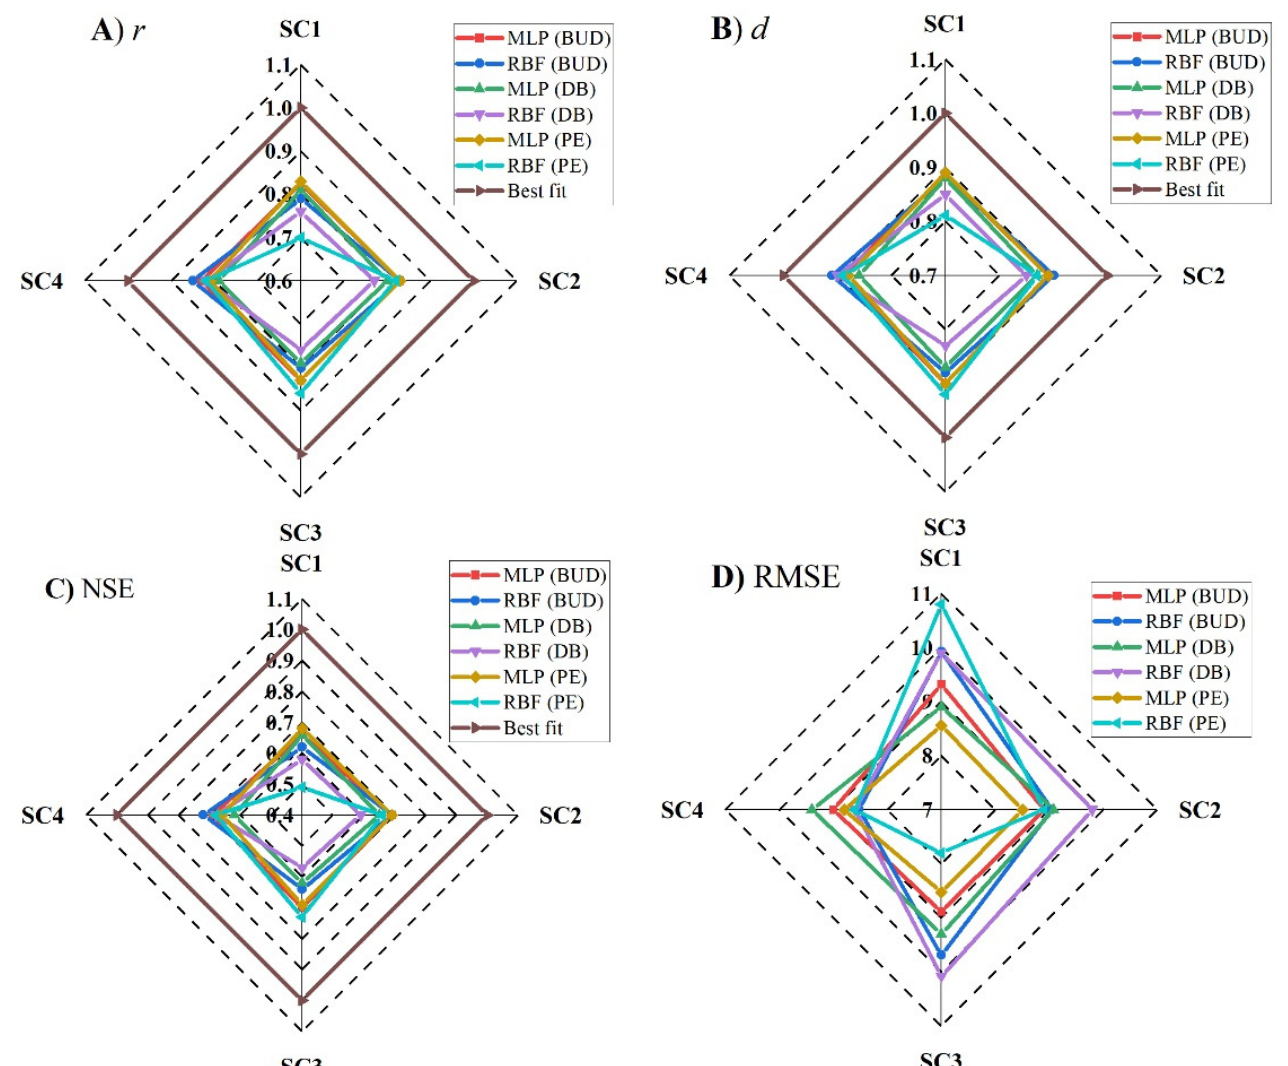
Figure 7. Performance analysis of ANN (MLP and RBF) algorithms in predicting MFI values under four scenarios (SC1, SC2, SC3, and SC4) at three stations in Budapest (BUD), Debrecen (DB), and Pecs (PE): ( A ) Pearson correlation coefficient ( r ), ( B ) index of agreement correlation ( d ), ( C ) model efficiency (NSE), and ( D ) root mean square error (RMSE).